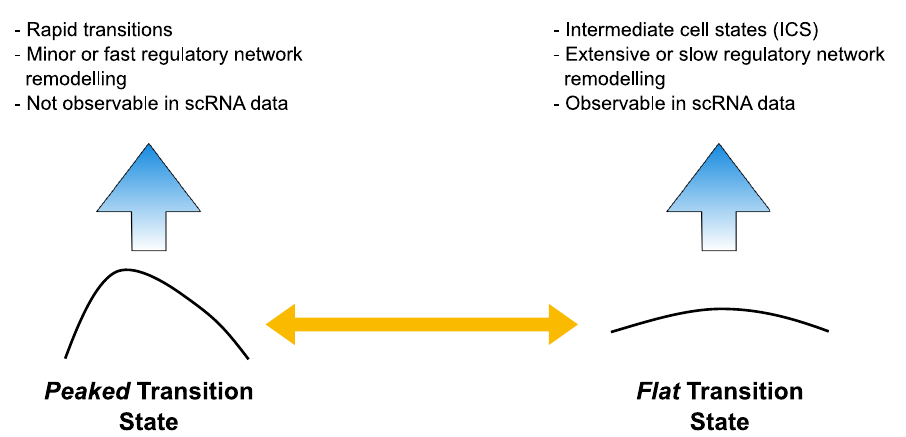
Fig 9. Relationship between transition state and observable data. The landscape curvature around the TS affects the time cells will spend in the vicinity of the TS, and reflects the molecular processes driving differentiation.